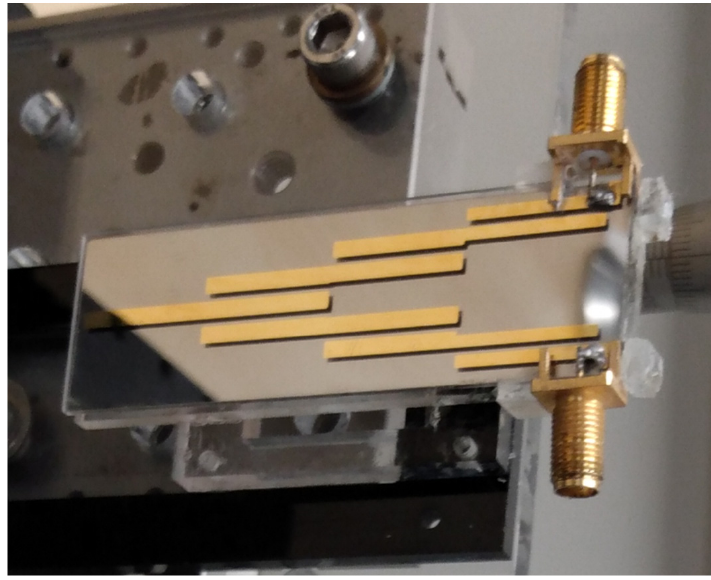
Figure 2. A fabricated gold microstrip band-pass filter on a quartz